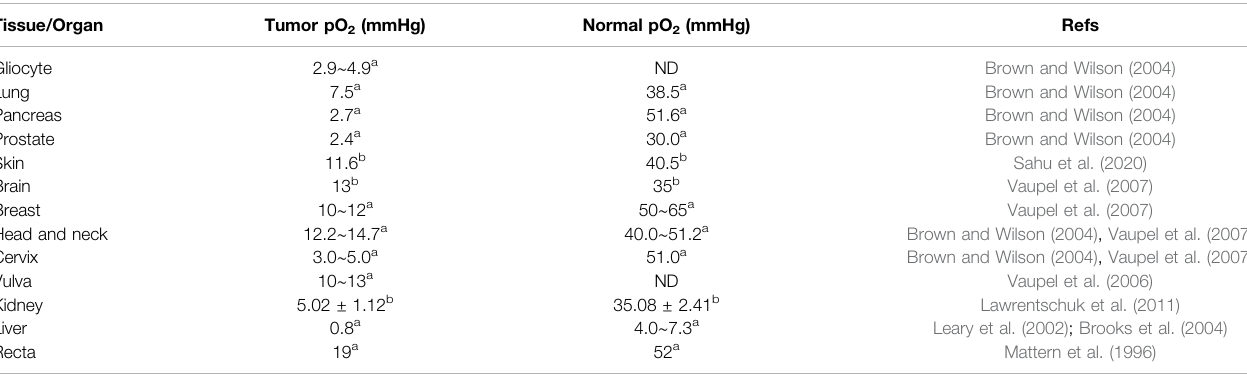
TABLE 1 | Typical pO 2 of major tumors and respective normal tissue/organ.